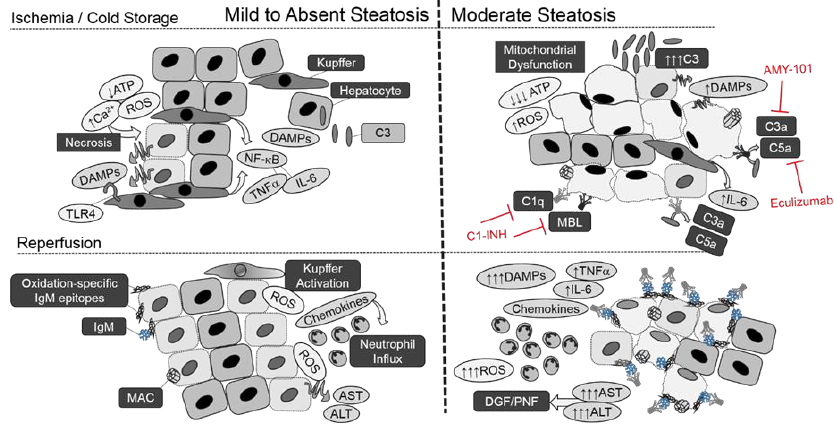
Figure 1. Overview of Aberrant Complement Activation in Hepatic Steatosis.